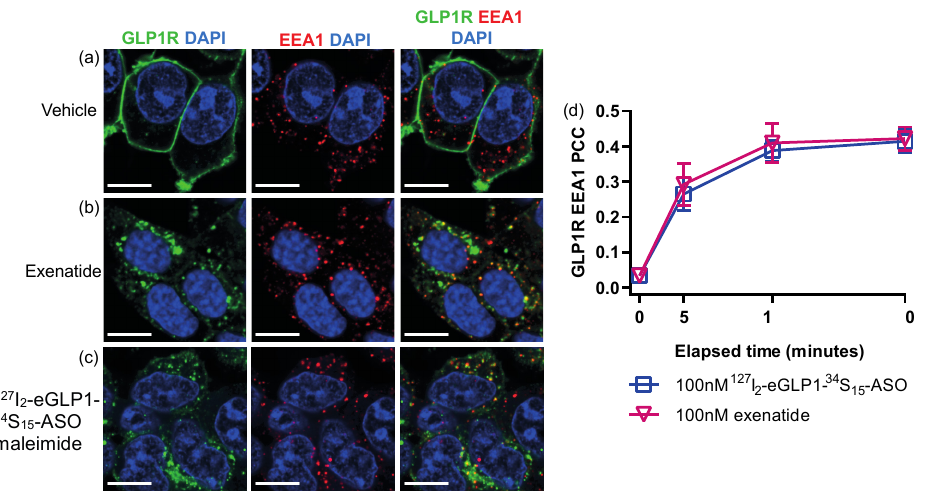
Figure 5. Representative confocal images of GLP1R and EEA1 following 30 min incubation with vehicle control ( a ), 100 nM exenatide ( b ), or 100 nM 127 I 2 -eGLP1- 34 S 15 -ASO ( c ). Nuclei were coun- terstained with DAPI. Pearson’s correlation co-efficient for GLP1R colocalization with EEA1 was calculated from cytoplasmic ROIs ( d ). All analyses are presented as mean ± SEM for 3 independent experiments. For each condition, cells from at least 10 fields of view were analyzed from at least 2 technical replicates per experiment. Scale bar = 10 µ m.